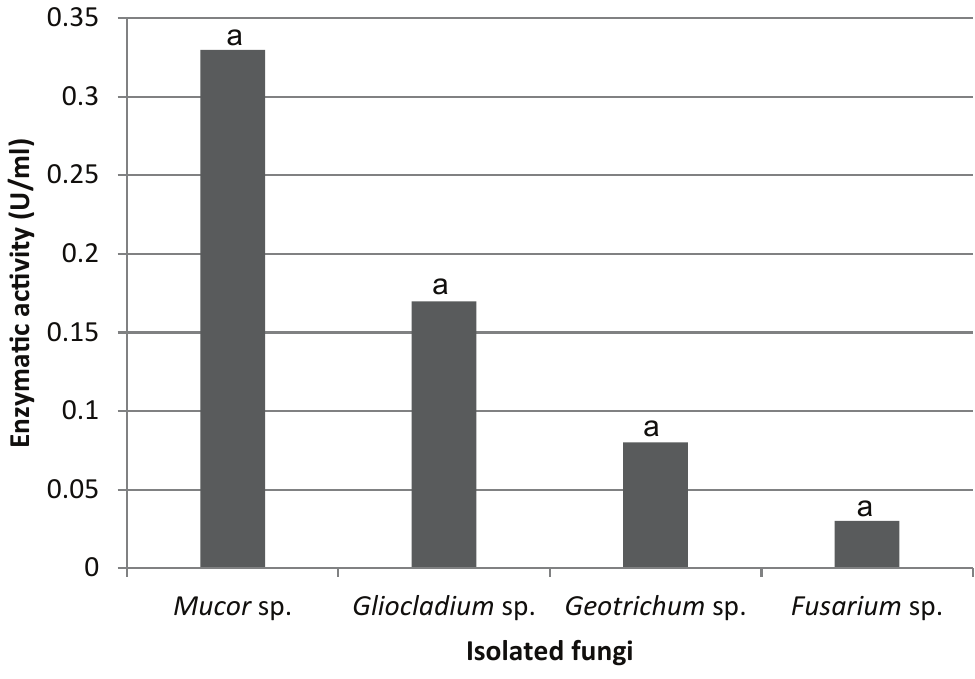
Figure 2 - Lipase enzymatic activity of filamentous fungi obtained from effluents of dairy products and slaughterhouses industries located in Pelotas/RS, Brazil. * a Letter ‘a’ indicates no statistically significant difference according to the Duncan test